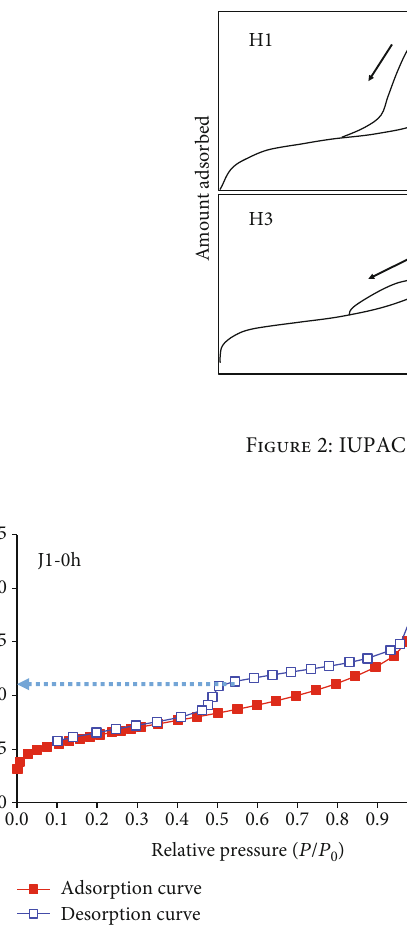
Figure 3: Low-pressure nitrogen sorption isotherms of shale soaked in slick water for di ff erent times.